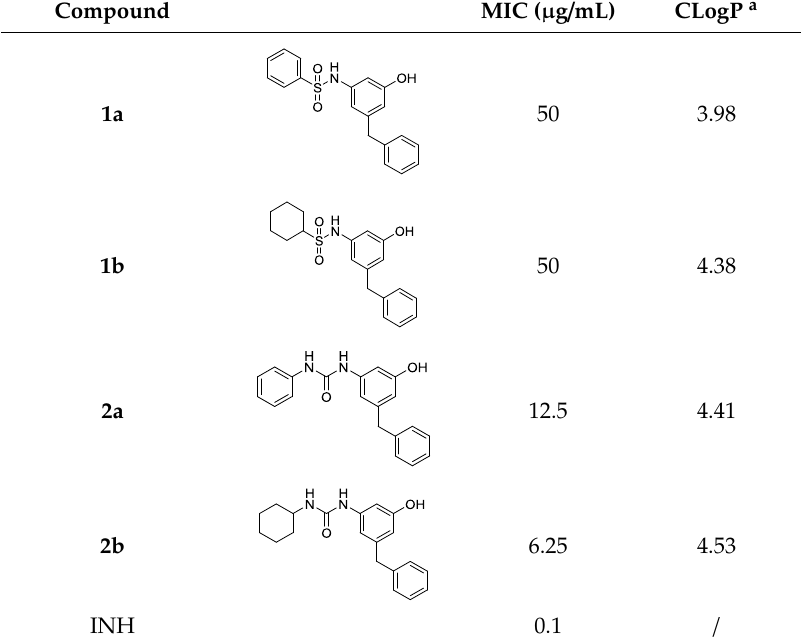
Table 1. Inhibitory activity of 1a – 1b and 2a – 2b against Mtb H37Ra.